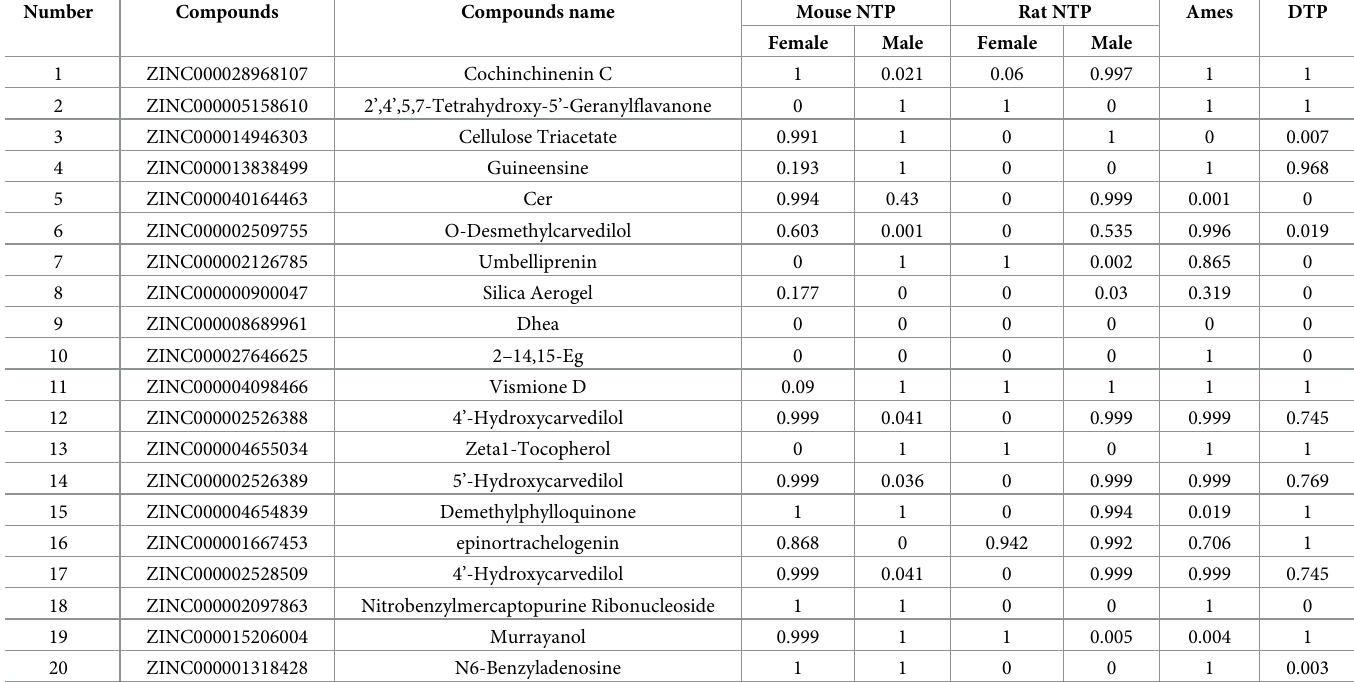
Table 3. Toxicities of